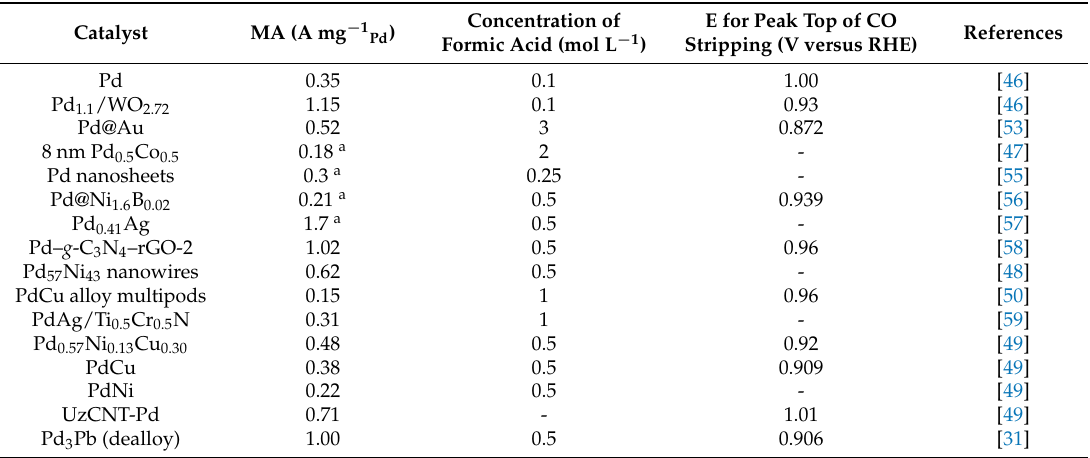
Table 1. Mass activities (MA) at 0.3 V versus the reversible hydrogen electrode (RHE) of various Pd-based catalysts for formic acid oxidation and CO